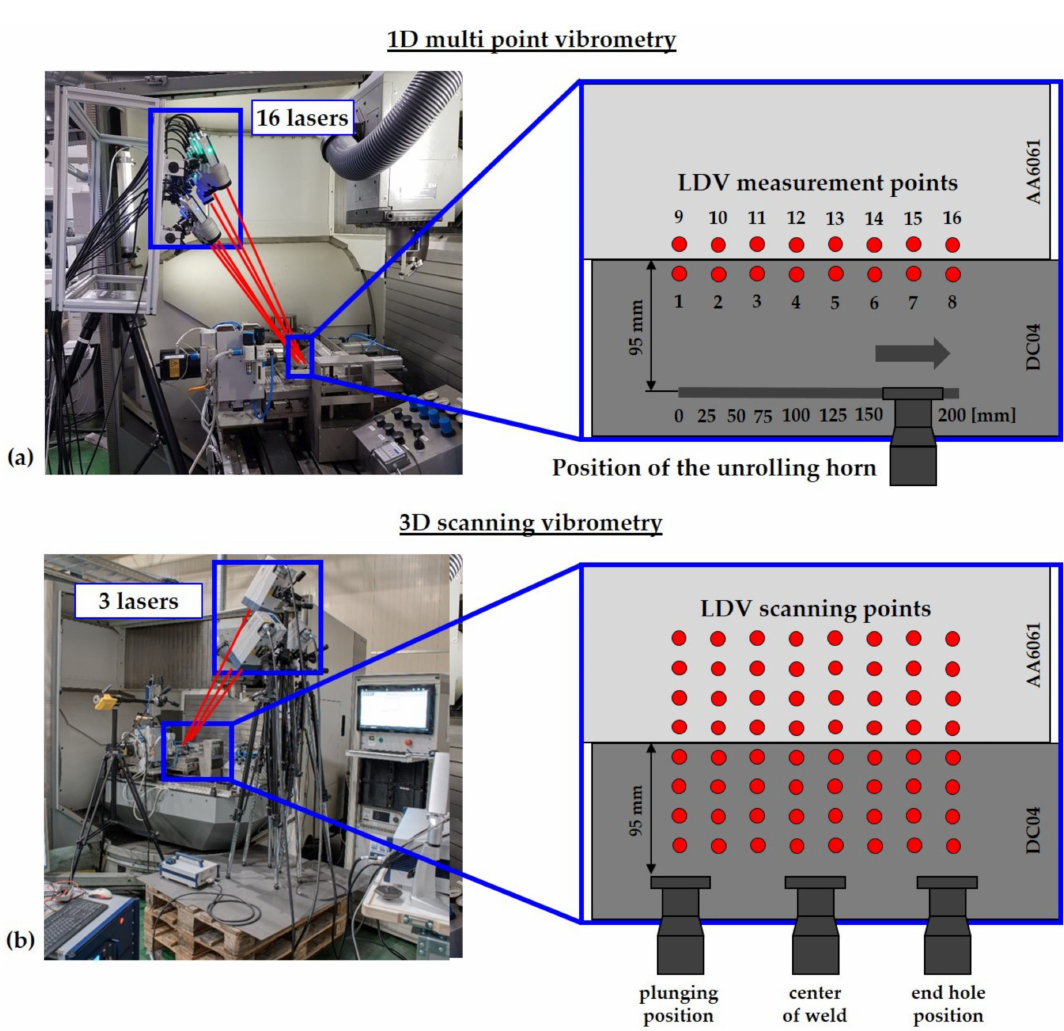
Figure 2. ( a ) Setup 1D multi point vibrometry with measurement points and position of the unrolling horn; ( b ) setup 3D scanning vibrometry with exemplary scanning points and static positions of the